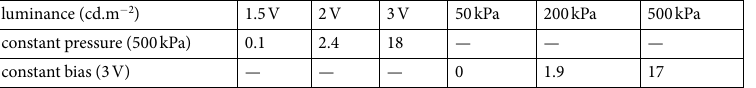
the emission from the high and low pressure areas. When pressure is applied using the tip of the finger to the light-emitting pressure-sensor devices, a round-shaped emission from the soft fingertip can be observed (right side) together with a line-like emission originating from the contact with the fingernail. Although the shapes of the emitting areas observed for the two flexible electrodes are similar, their intensity and, more specifically, the